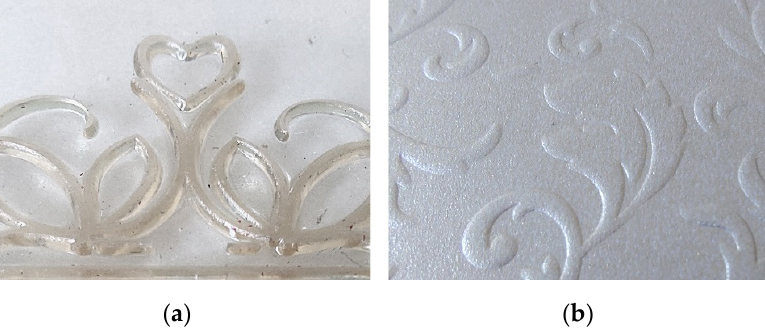
Figure 1. Segment of the ( a ) printing plate and ( b ) embossed image.